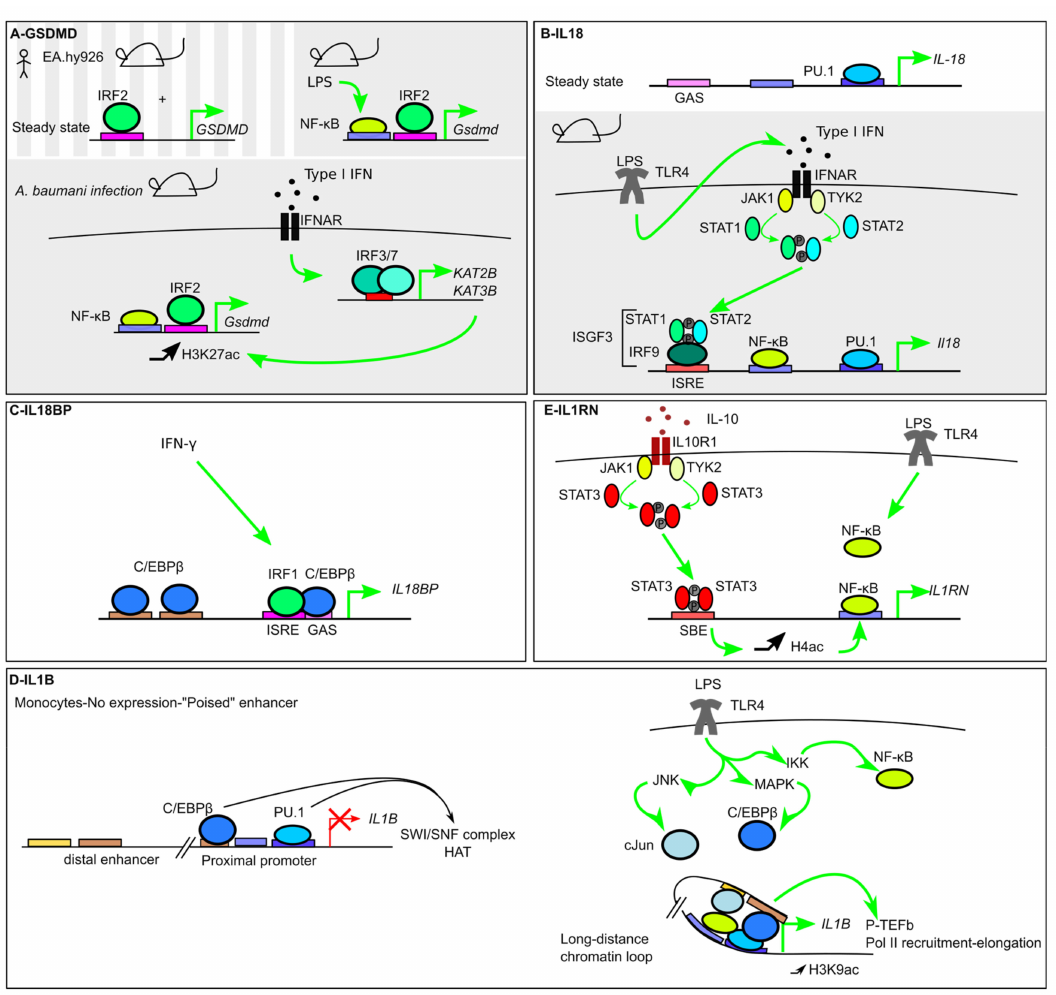
Figure 4. Transcriptional regulation of inflammasome substrates. ( A ) In mice and in the human endothelial EA.hy926 cell line, GSDMD constitutive expression is controlled by IRF2. During